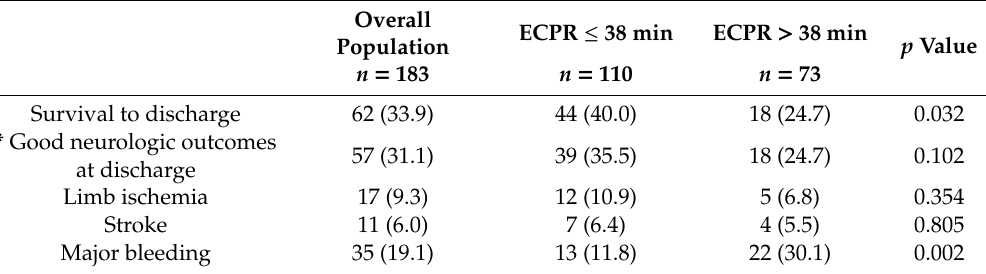
Table 3. Clinical outcomes and